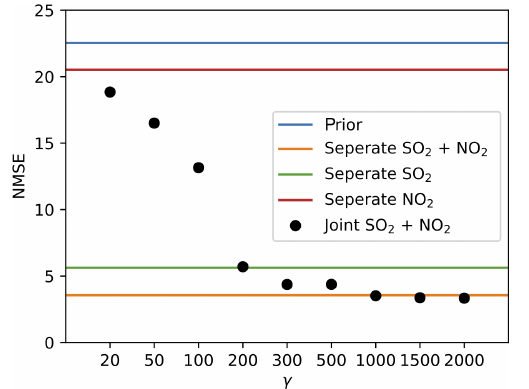
Figure 11. Sum of normalized mean squared error (NMSE) of sur- face SO 2 and NO 2 . All surface SO 2 and NO 2 simulations come from MIX-DDC and NL-DC, respectively. Black dots are posterior simulations from Joint-F-POS. The blue line shows prior simula- tion results with SO 2 NMSE from MIX-DDC-PRI and NO 2 NMSE from NL-DC-PRI. The orange line shows simulation results with SO 2 NMSE from MIX-DDC-POS and NO 2 NMSE from NL-DC- POS. The green line is similar to the orange line, but the posterior SO 2 emission from separate assimilation and prior NO x emission are used. The red line is similar to the orange line, but the posterior NO x emission from separate assimilation and prior SO 2 emission are used.